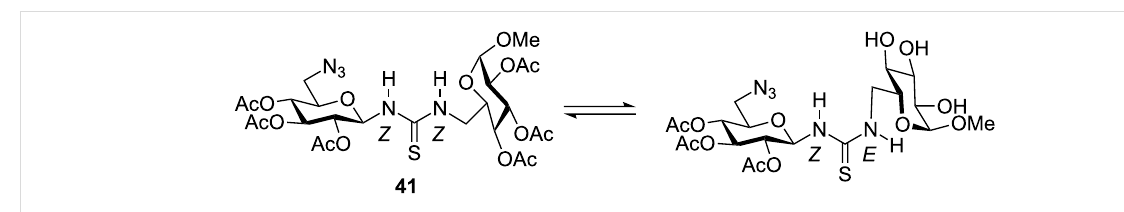
Figure 18: Rotameric equilibria for β -(1 → 6)-thiourea-linked glucodimer 41 .